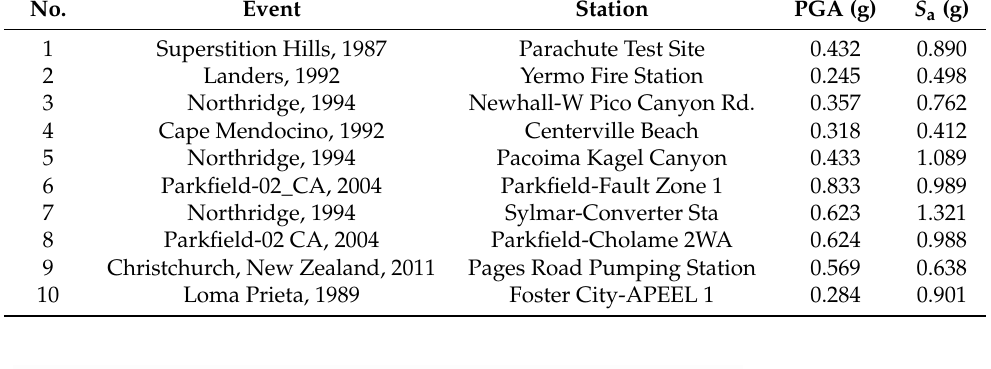
Table 4. Ground motion records for dynamic time-history analysis.